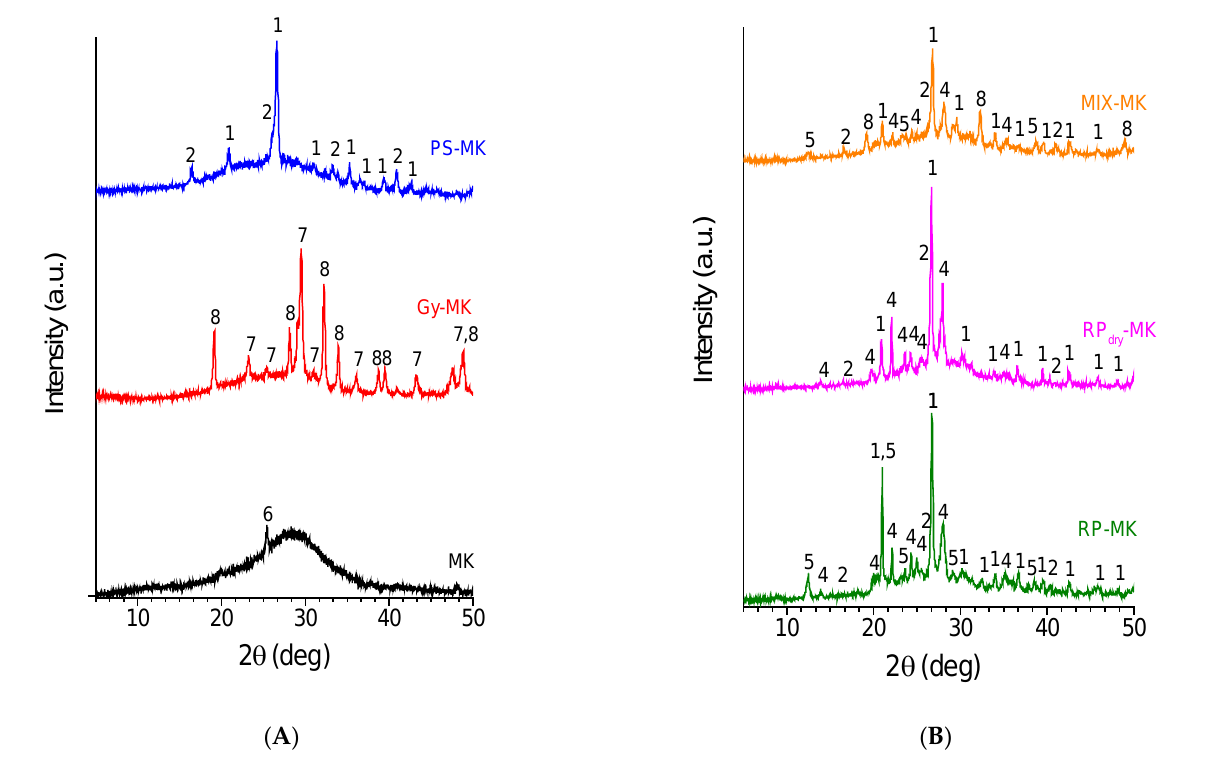
Figure 2. X-ray diffraction pattern of ( A ) geopolymer (MK) and geopolymeric mortars loaded with porcelain stoneware waste (PS-MK), gypsum waste (Gy-MK), and ( B ) geopolymeric mortars loaded with raw pressed (RP-MK) and annealed raw pressed (RP dry -MK) waste. Also in ( B ), the X-ray diffraction pattern of the MIX-MK mortar obtained with the aggregate mixtures described in Table 2 is reported. The numbers correspond to the main diffraction peaks of 1-Quartz (SiO 2 ) (01-083-0539); 2-Sillimanite (Al 2 SiO 5 ) (01-088-0893); 3-Gypsum (CaSO 4 ·2(H 2 O)) (00-003-0053); 4-Albite (NaAlSi 3 O 8 ) (01-089-6427); 5-Kaolinite (Al 2 Si 2 O 5 (OH) 4 ) (01-080-0886); 6-Anatase (TiO 2 ) (01-070-7348); 7-Calcite (CaCO 3 ) (01-080-9776); and 8-Thenardite (Na 2 SO 4 ) (04-010-2457). Table 3. Degrees of crystallinity ( x c , %) of the starting raw waste and corresponding geopolymeric materials obtained by geopolymerization reaction, whose diffraction patterns are reported in Figures 1 and 2.